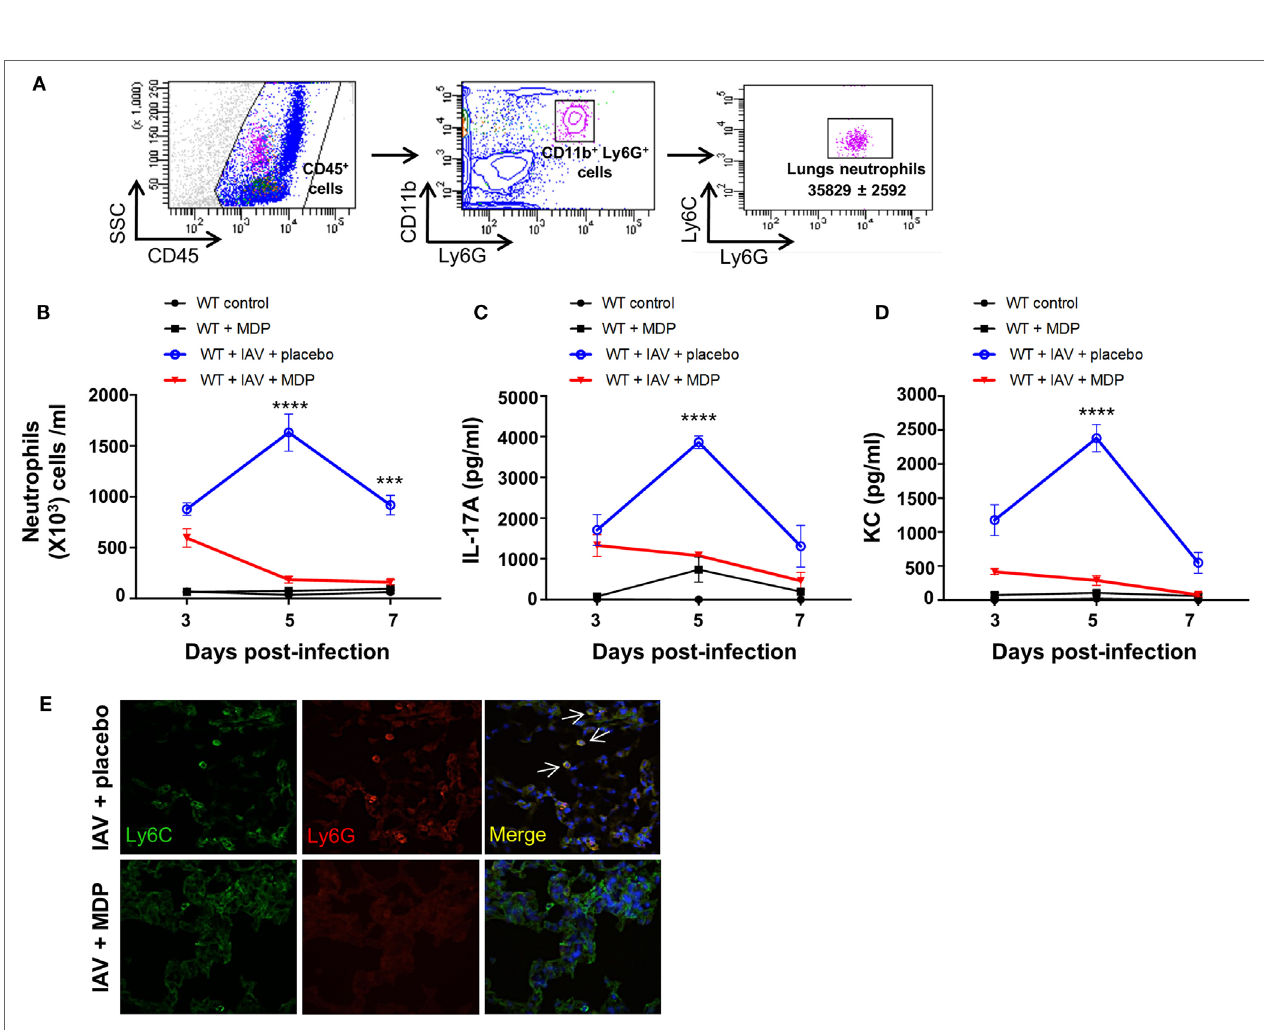
FigUre 2 | Muramyl dipeptide (MDP) treatment reduces neutrophils migration to the lungs of influenza A virus (IAV)-infected mice. (a) Representative gating strategy of lungs neutrophils (CD45 + , CD11b + , Ly6G + , Ly6C + ) in wild-type (WT) naive mice. (B) Number of neutrophils was measured in lung tissues of IAV-infected mice treated with MDP or placebo at indicated time post-infection. Levels of (c) IL-17A and (D) KC were determined in lung homogenates of IAV-infected WT mice daily treated with placebo or MDP. Lungs were collected at days 3, 5, and 7 postinfection. Results are presented as mean ± SEM of two independent experiments ( n = 4 mice/groups). Differences in groups were determined with two-way analysis of variance followed by a Tukey post hoc test. *** p < 0.001 and **** p < 0.0001, as compared to IAV-MDP-treated mice (e) Immunofluorescence analysis of lungs sections from IAV-infected mice daily treated with placebo or MDP. Lungs were extracted at day 5 postinfection and lung sections were stained with Hoechst (blue), Ly6C (green), and Ly6G (red) antibodies. Arrows show Ly6C + and Ly6G + neutrophils. Images are representative of one experiment ( n = 4